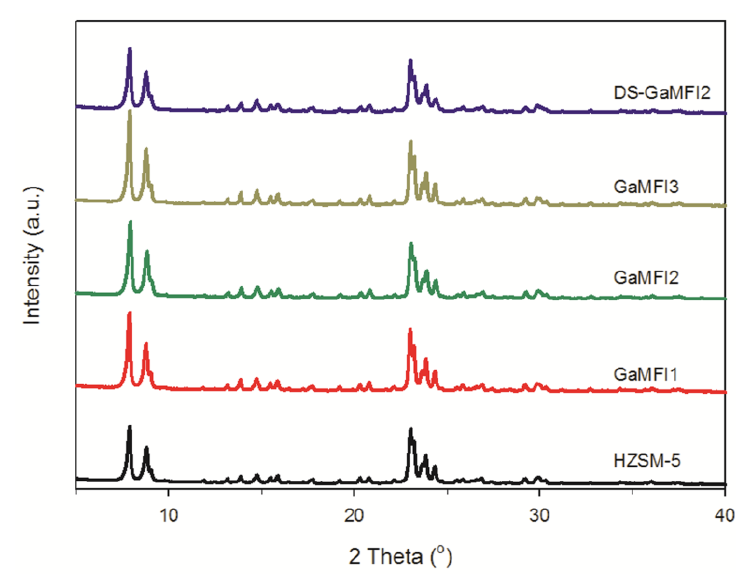
Figure 1. XRD patterns of HZSM-5 and Ga-containing MFI zeolites.